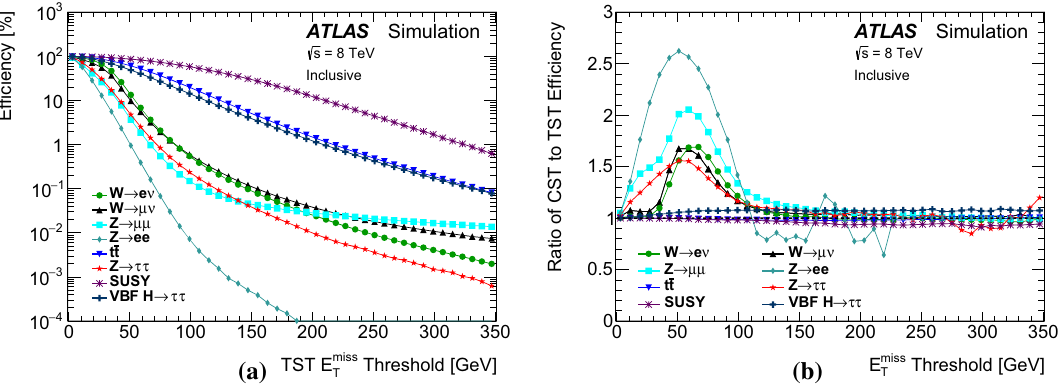
Fig. 16 a The selection efficiency with TST E miss In both cases, results are shown for several